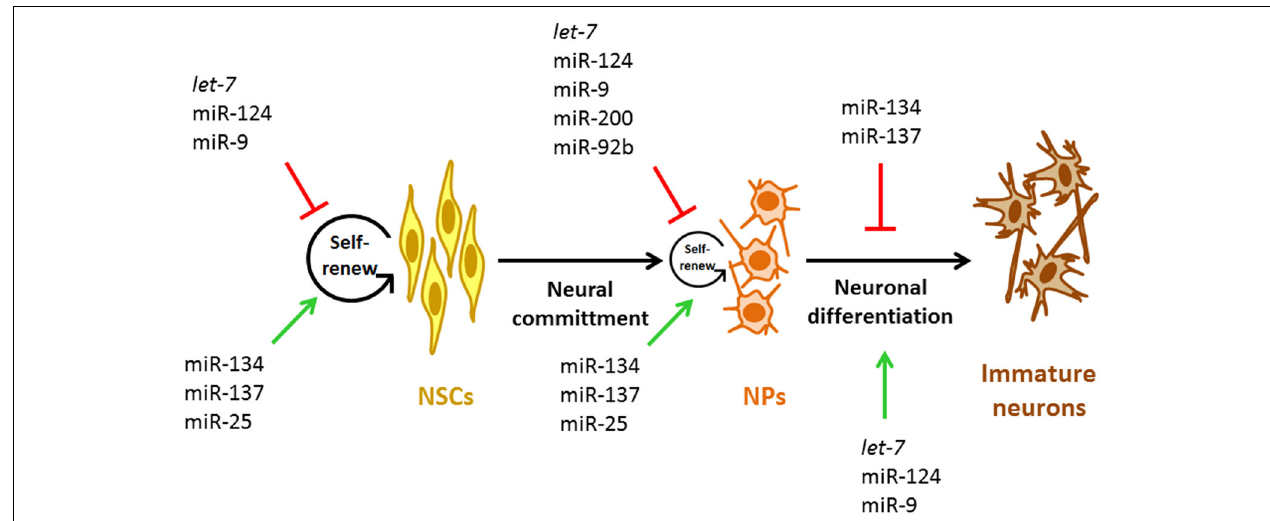
FIGURE 2 | miRNAs involved during early neurogenesis. Representative miRNAs involved in the control of self-renewal and proliferation of NSCs and NPs and in the early stage neurogenesis. NSCs, neural stem cells; NPs, neural progenitors.